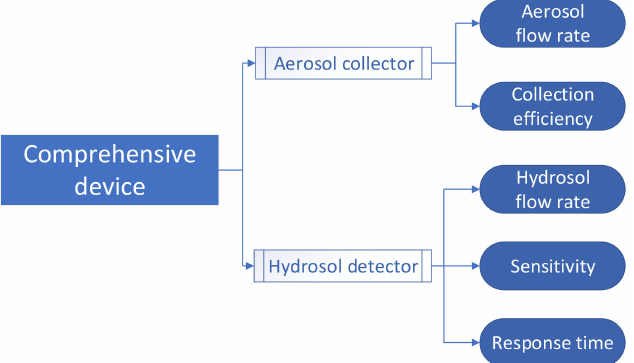
Figure 4. Properties and critical performance parameters determined by the aerosol collector and hydrosol detector in airborne virus detection